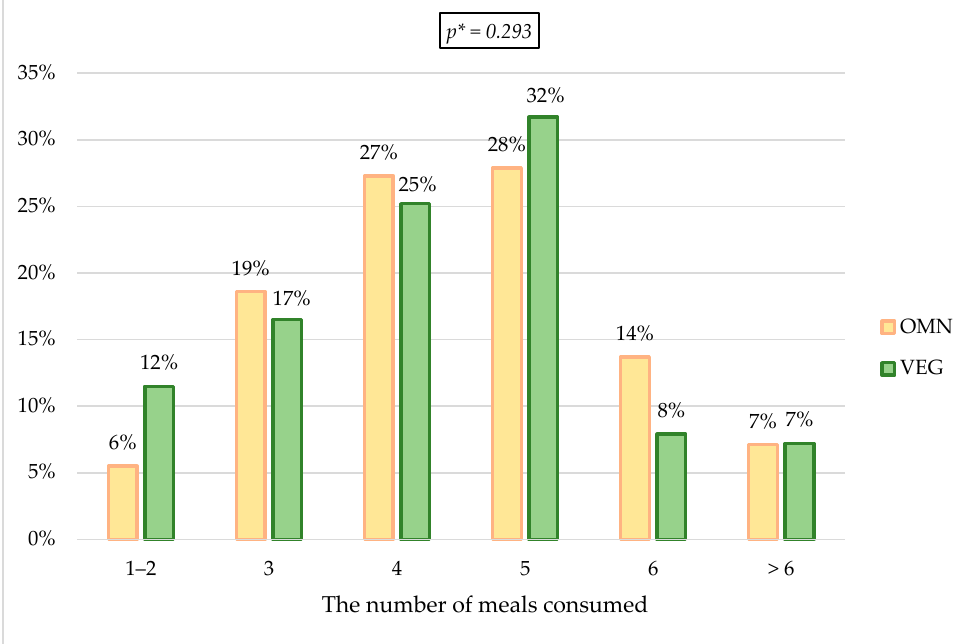
Figure 4. Changes in the number of meals during the pandemic. * p —calculated between the studied groups using Mann-Whitney U Test.